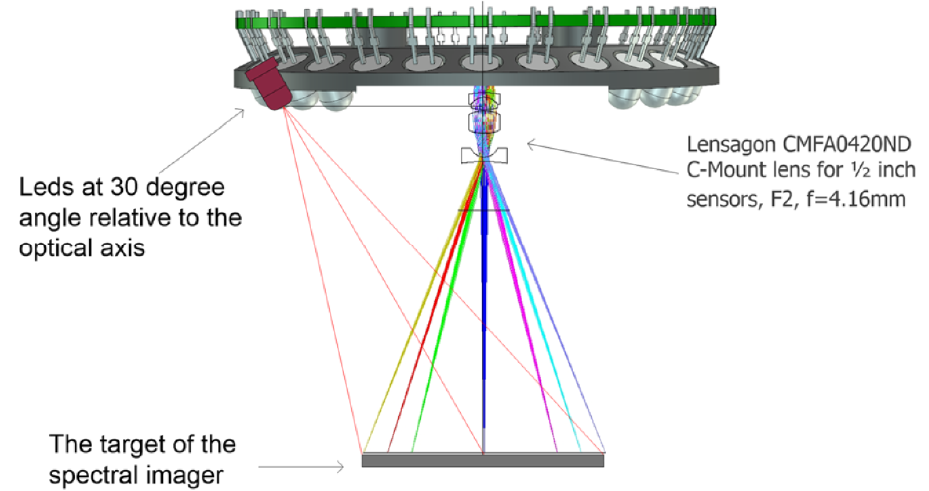
Figure 3. Three sets of nine LEDs are at a 30-degree angle relative to the system’s optical axis. These three same wavelength LEDs sets are located at 120-degree intervals on the Led